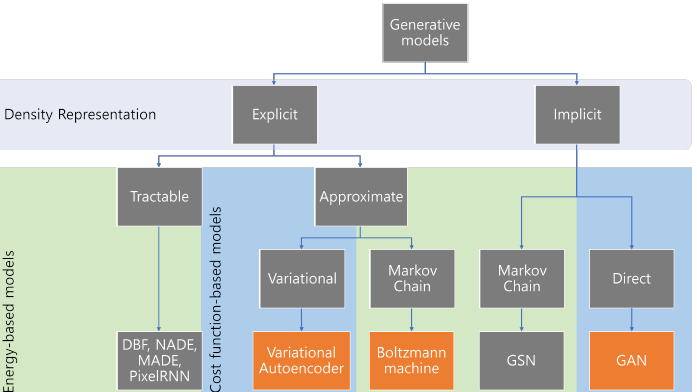
Figure 5. Classification of generative models: this figure is modified version of [82,83]. Orange color specifies the most popular models.